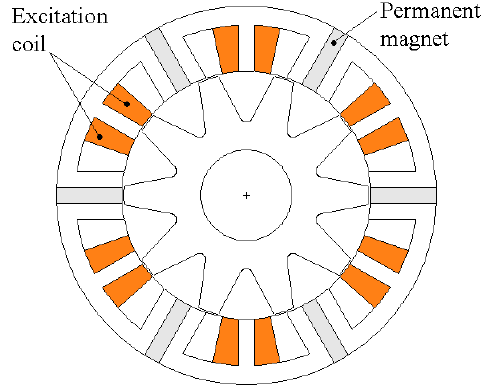
Figure 3. Doubly salient hybrid excited structure (inner rotor) [46]. Figure 4 shows a new hybrid excited structure where the electromagnetic field sources (permanent magnets, excitation windings and armature windings) are all located in static parts, but armature windings and excitation field sources (permanent magnets and excitation windings) are placed in separate stators. The rotor is completely passive. This structure helps overcome one of the drawbacks of previous flux-switching machines by a better space utilization. Magnetic saturation should appear for higher values of current densities, which should help improve the torque density [19,47]. Figure 4. Separate stators hybrid excitation machine.